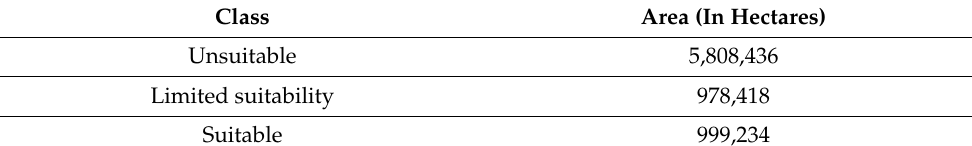
Table 9. Overall land area suitable for Sitka spruce (biophysical and policy constraints).